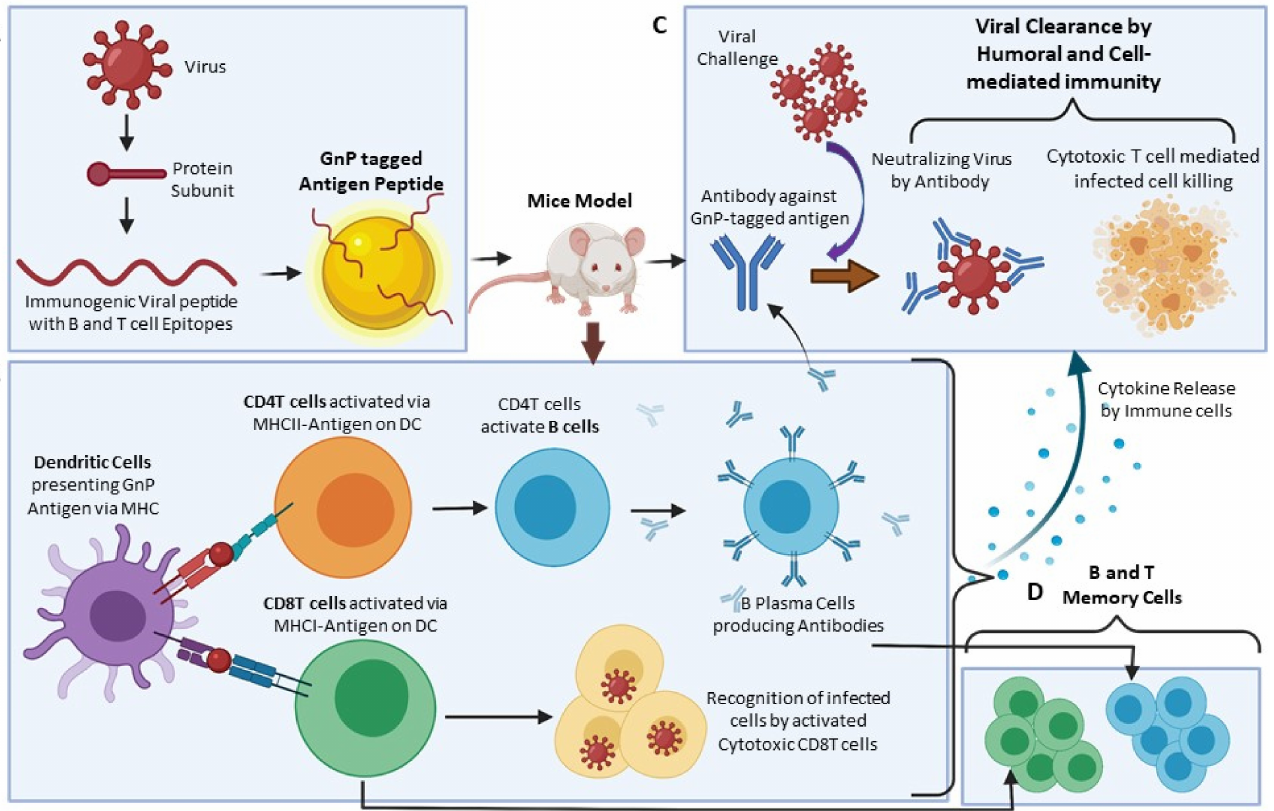
Figure 2. A schematic representation of the use of GNPs in developing nanovaccines against a virus. ( A ) The protein subunit from the virus is isolated to determine the peptide sequence, which is both immunogenic for the host and conserved across multiple strains of the virus. The peptide is tagged with GNPs to create the novel nanovaccine and tested on the mice model. ( B ) The immune cells of the mice are triggered as the dendritic cells start presenting the peptides to the CD4 helper T cells and the CD8 cytotoxic T cells. The clonal expansion of the activated helper T cells and subsequent activation of the B cells into the plasma cells lead to the production of the antibodies specific to the peptide used for nanovaccine production. The cytotoxic T cells can recognize and deploy themselves in the killing of the infected cells. ( C ) The cytokines produced during the process of immune regulation of the nanovaccine produce a chemical milieu where the immune cells can favorably fight against the pathogens and shape the Th1 or Th2 immune response depending on the inflammation status. The antibodies can recognize the peptide sequence present in the whole virus and neutralize them effectively. ( D ) The B and T memory cells formed during this vaccination process can hold the information of the peptide used during the process and live long after. They are equipped to start an immediate immune response against any future challenge of the same virus and thus can eliminate them before they can cause major harm to the